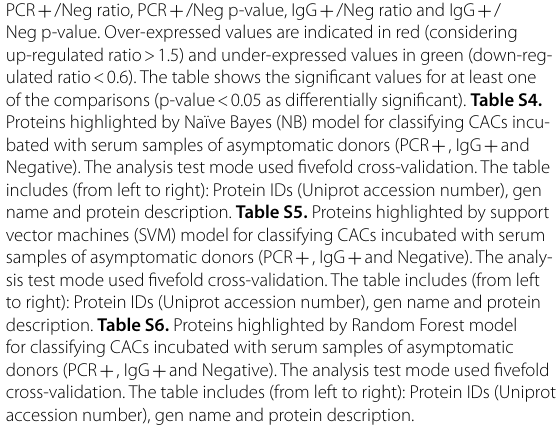
samples. The table includes (from left to right): Number of serum + sample, PCR test for virus detection results, ELISA test for IgM and IgG detection results. Table S2. Quantitative analysis of proteins differentially expressed in serum samples ( vs Neg). The table includes (from left to right): Protein IDs (Uniprot accession number), protein description, PCR Neg ratio,